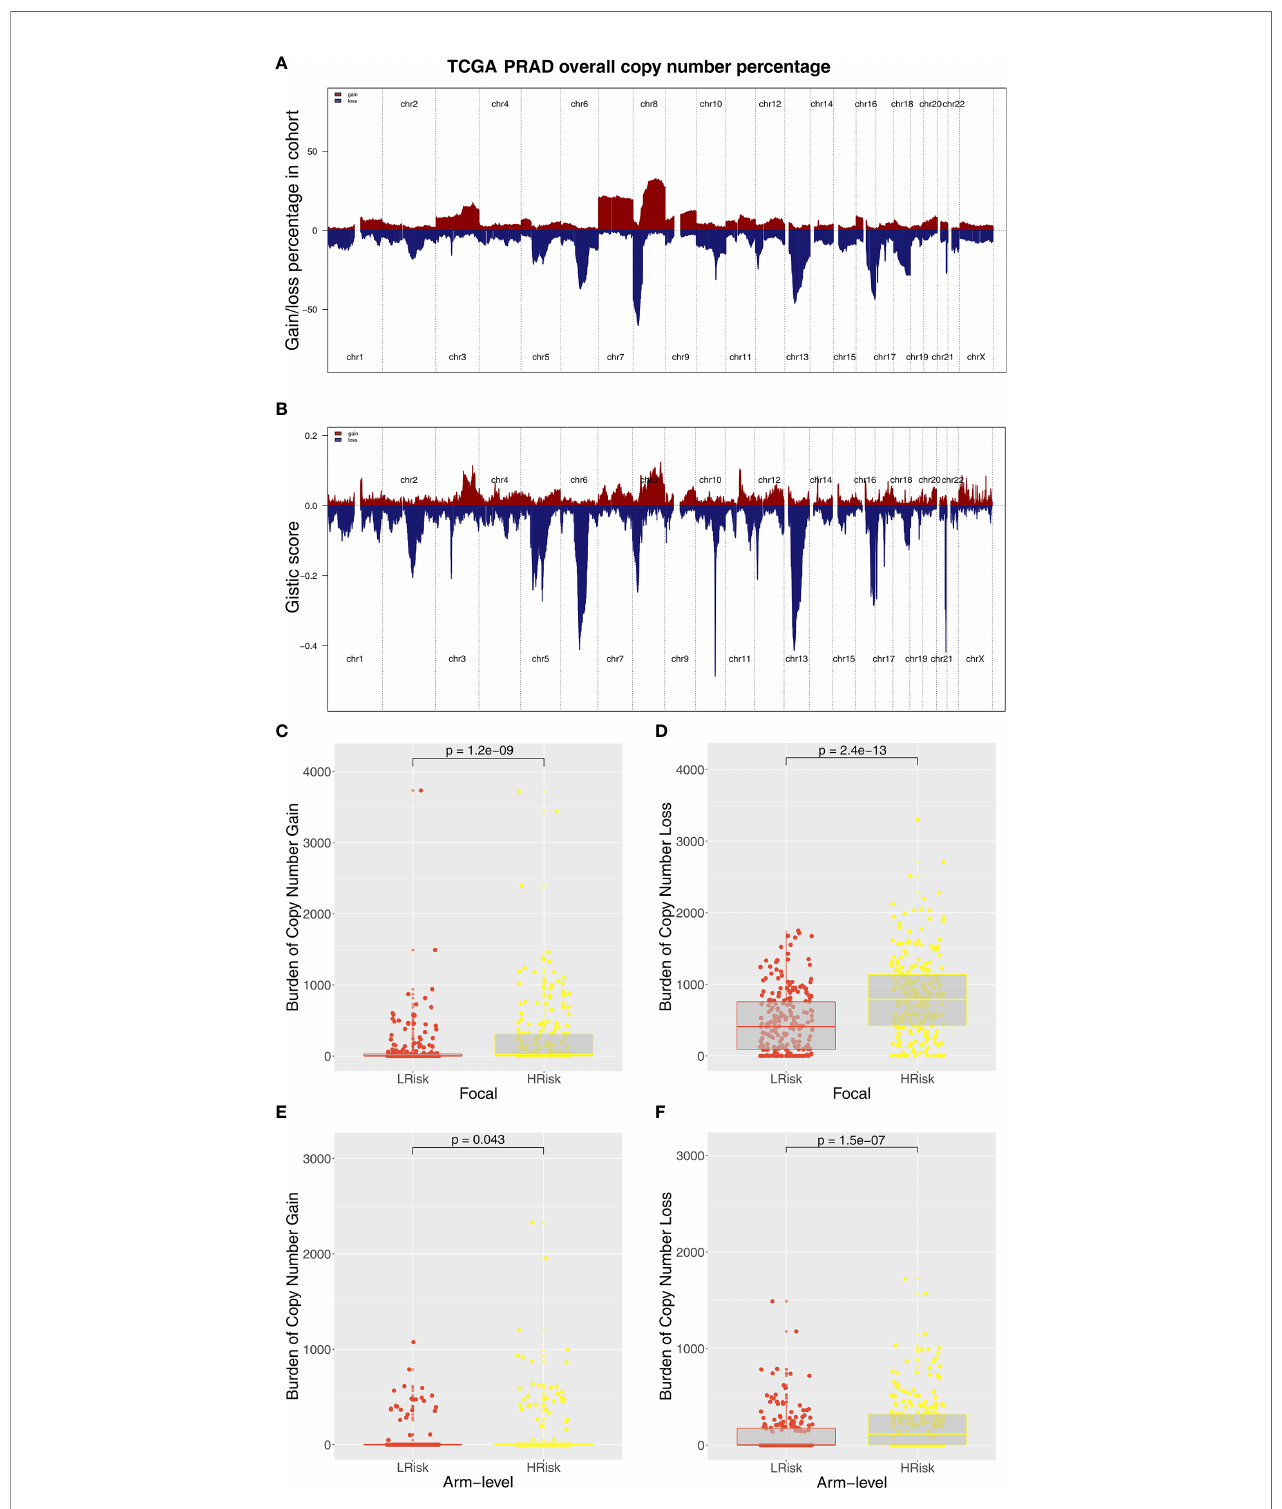
FIGURE 6 | Composite copy number pro fi les of TCGA-PRAD. (A) The gain and loss percentage of copy number pro fi les of TCGA-PRAD. (B) The gistic score of copy number pro fi les of TCGA-PRAD. (C, D) High IRS PRAD patients showed a higher focal level of CNV burden. (E, F) High IRS PRAD patients showed a higher arm level of CNV